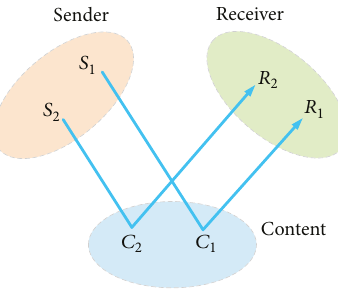
Figure 1: Relationship of three entities in information diffusion